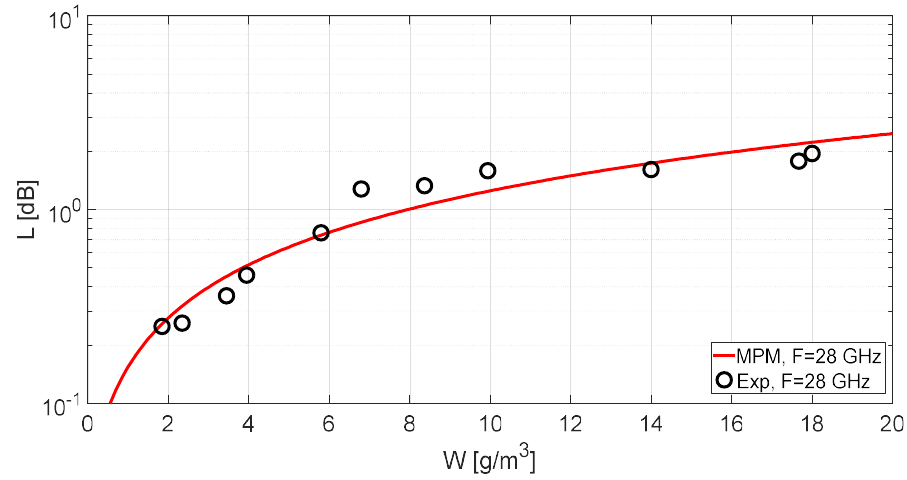
Figure 12. Simulation and experiment results for the attenuation mmW at 28 GHz. The environmental conditions are: T = 16 °C, P = 101 KPa, RH = 100%.